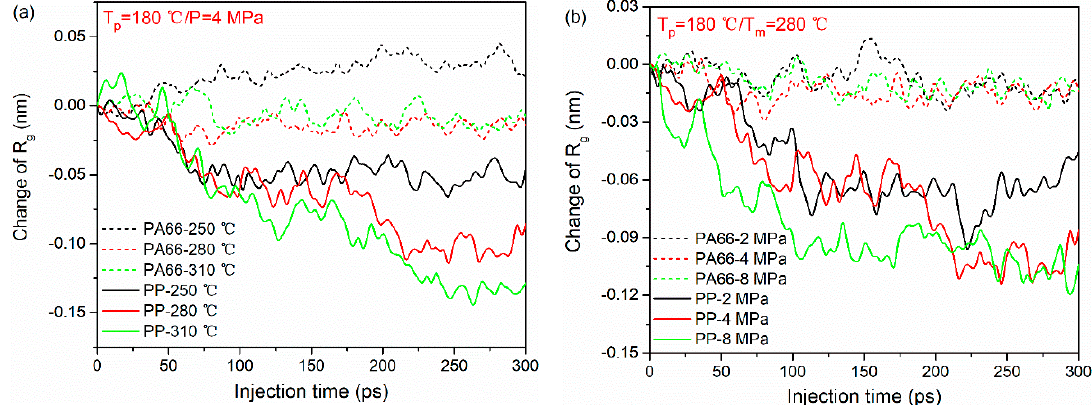
Figure 5. Radius of gyration of PA66 and PP during bonding process under different processing parameters: ( a ) melting temperatures and ( b ) injection pressure.